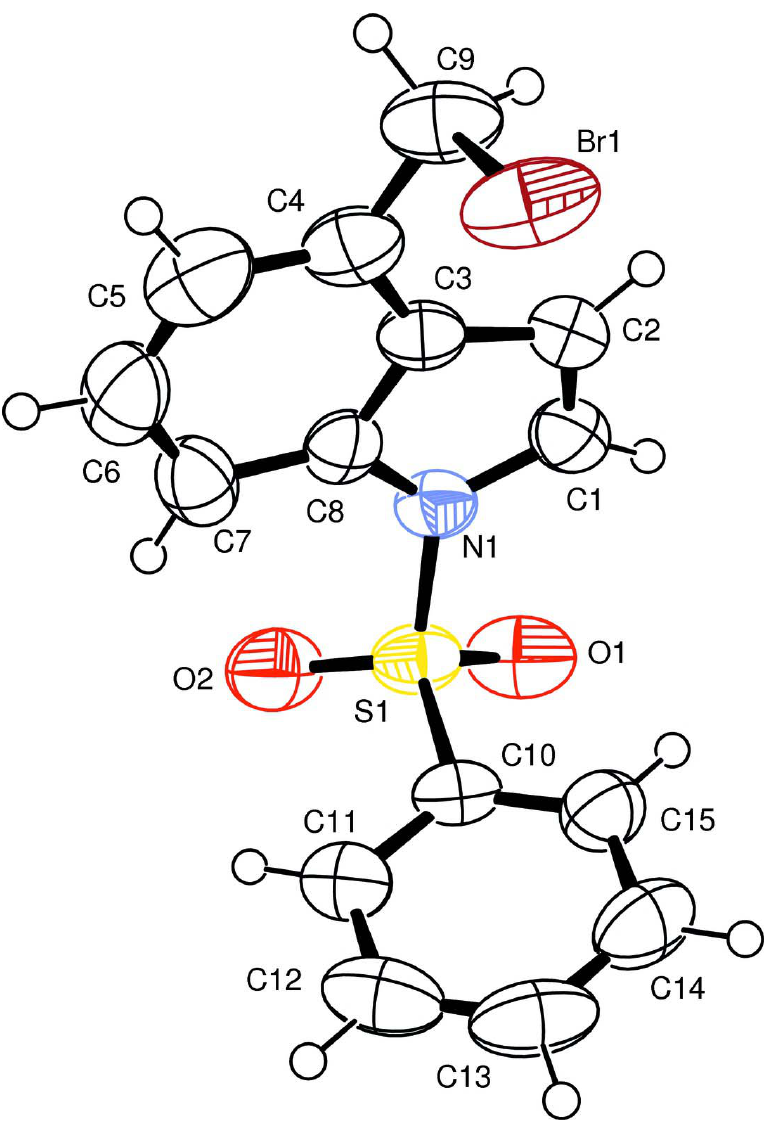
The molecular structure of (I) showing the atomic labels and 50% probability displacement ellipsoids for non-H atoms. Only major parts of the disordered atoms are